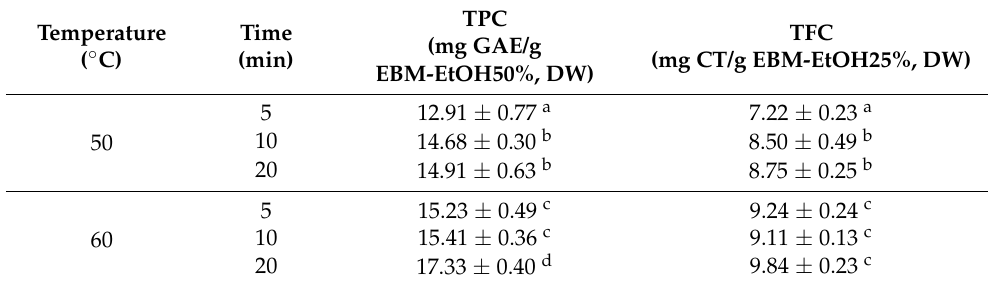
Table 4. Effect of the time of extraction of total polyphenols content (TPC) and total flavonoids content (TFC) of EBM-EtOH50% and